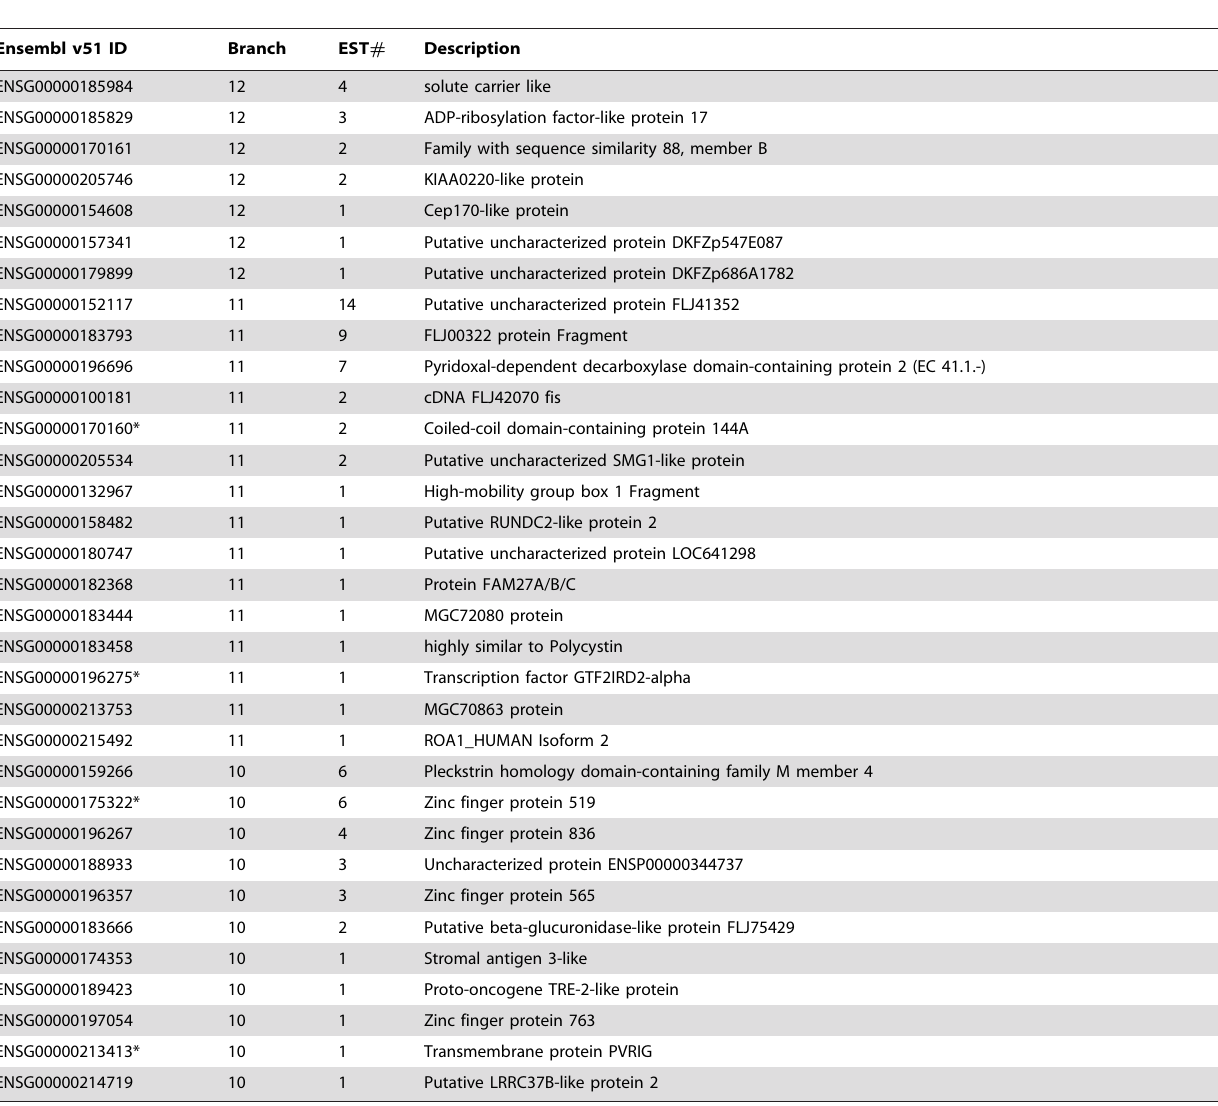
Table 3. PFC biased hominoid-specific genes with at least one fetal or infant brain ESTs.